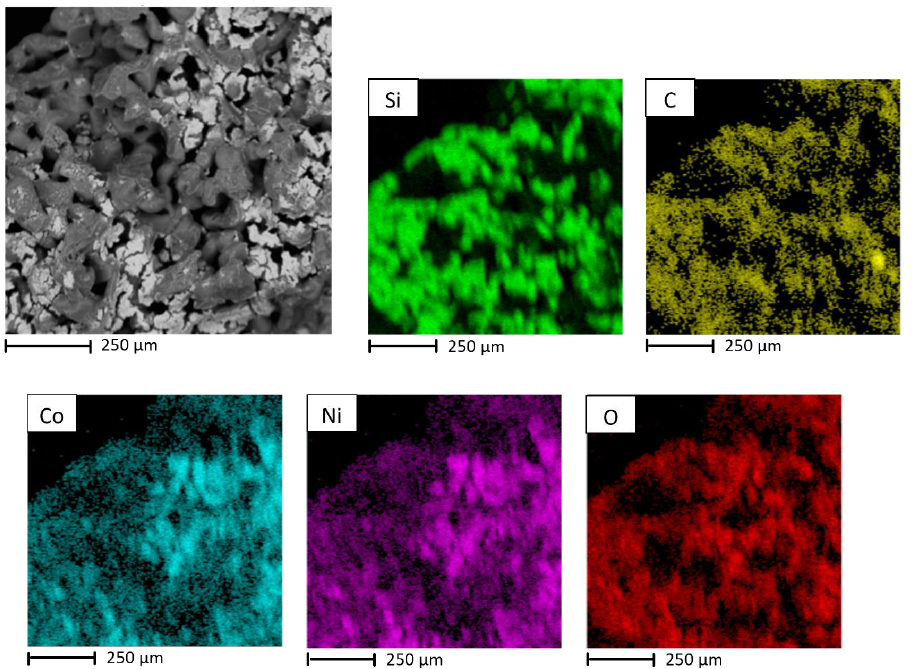
Figure 5. SEM/EDX images relative to sample NiCoAl_C_SiC.